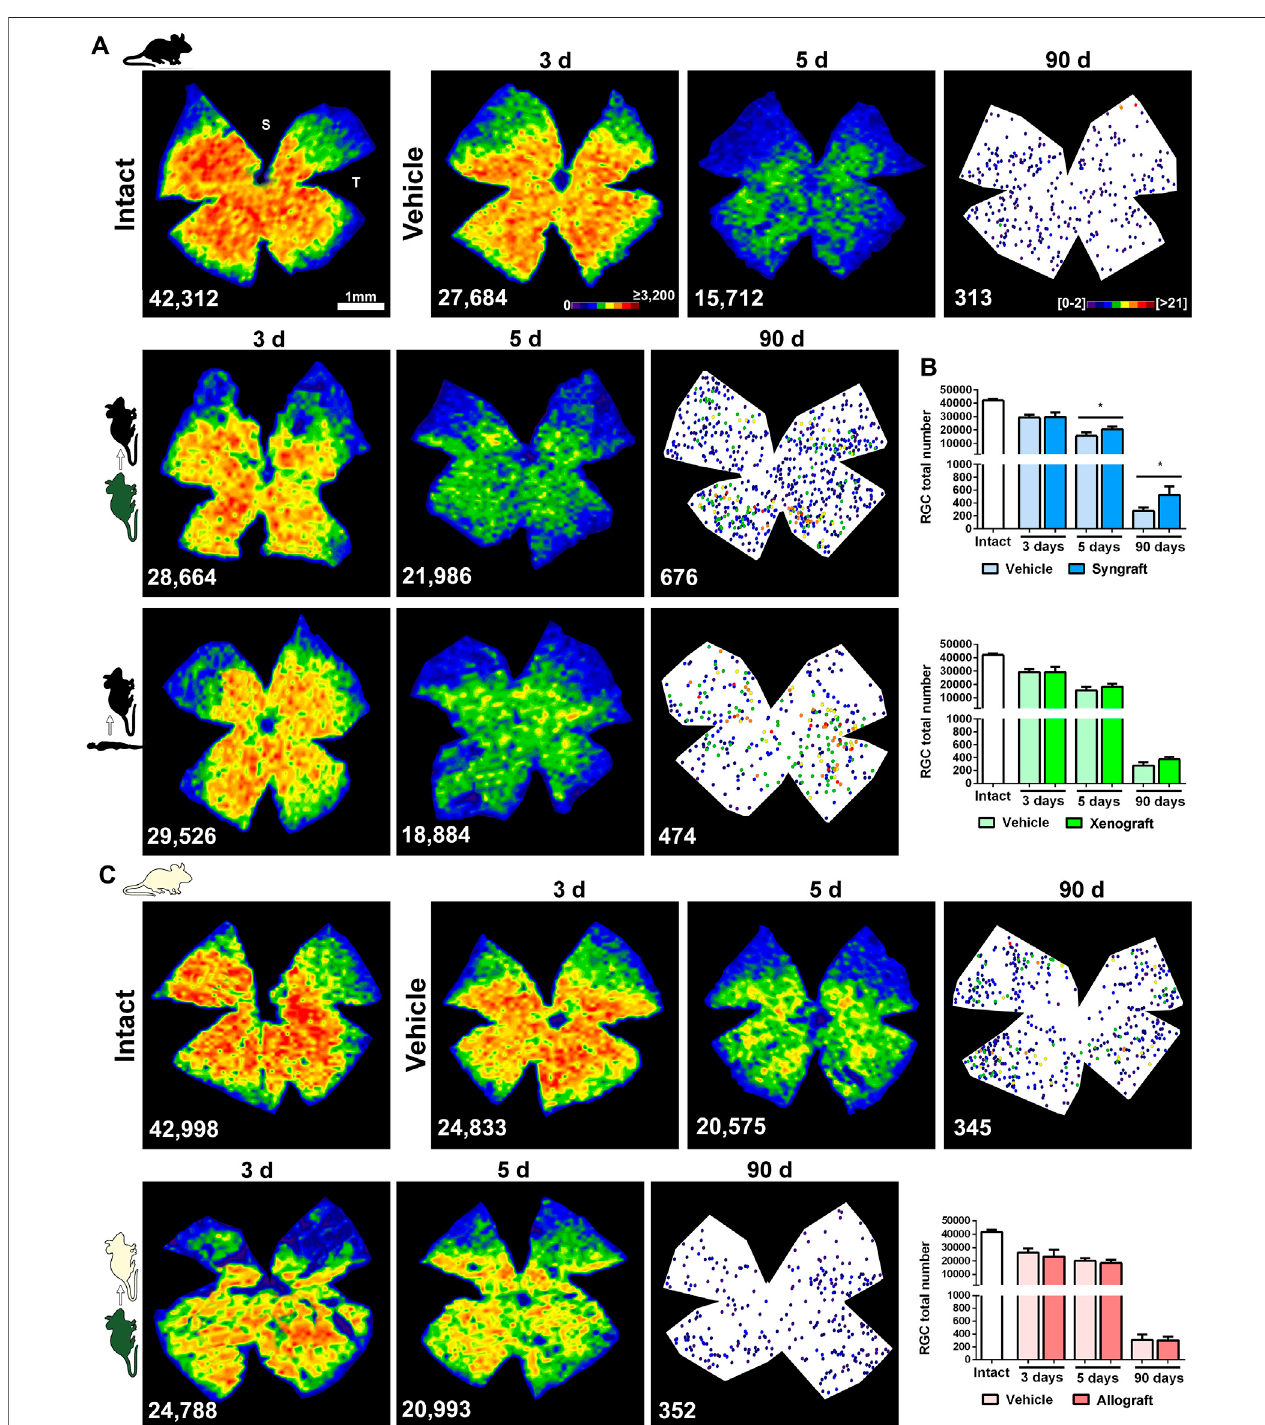
FIGURE5| Syngeneictransplantneuroprotectsvision-formingRGCs. (A) :Representativeisodensitymaps(intactand3and5 daysafterONC)orneighbourmaps (90 days after ONC) showing the distribution of RGCs in intact, ONC + vehicle, ONC + mBM-MSCs and ONC + hBM-MSC retinas from the C57/BL6 strain. (B) : Bar graphs showing the total number of Brn3a + RGCs ± SD in syngeneic (top) and xenogeneic (bottom) transplanted retinas and their controls (* p < 0.05, non-parametric Mann-Whitney test). (C) : Representative isodensity maps (intact, and 3 and 5 days after ONC) or neighbour maps (90 days after ONC) showing the distribution of RGCs in intact, ONC + vehicle and ONC + mBM-MSCs retinas from the Balb/c strain. (D) : Bar graphs showing the total number of Brn3a + RGCs ± SD in allogeneic transplantedretinasandtheircontrols.AtthebottomofeachmapisshownthenumberofRGCscountedintheoriginalretina.Colourcodesforisodensityandneighbour maps appear in the fi rst row. For more details see methods. n (cid:2) 5 animals/group/time point at 3 and 5 days, and n (cid:2) 4/group at 90 days.